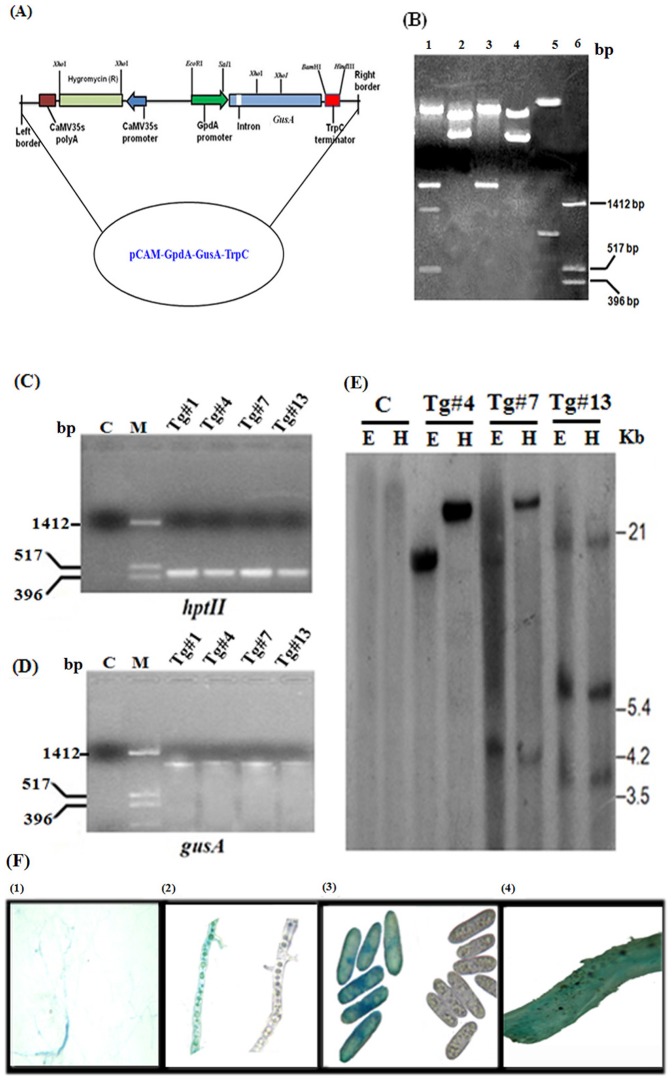
Standardization of Agrobacterium-mediated transformation of Colletotrichum fungus with the gusA reporter gene expression construct, pCAM-GpdA-GusA-TrpC.(A) Schematic diagram of the genetic construct prepared in pCAMBIA1300 binary vector. (B) Ethidium bromide-stained 1.2% agarose gel showing characteristic restriction enzyme digestion profile of the genetic construct with XhoHI (lane 1), EcoRI+HindIII (lane 2), EcoRI+SalI (lane 3), EcoRI+BamHI (lane 4) and BamHI+HindIII (lane 5) along with the pUC18 DNA digested with Hinf1 as molecular weight marker (lane 6). (C) PCR-based screening for the presence of 450 bp hptII selection marker gene-specific amplicon in four (Tg#1, Tg#4, Tg#7 and Tg#13) chosen transformed lines. (D) PCR-based screening for the presence of 1100 bp gusA reporter gene-specific amplicon in the same four transformed lines. In (C) and (D), Lane M =  HinfI digested pUC18 DNA as molecular weight marker (E) Confirming genomic integration of the gusA transgene through Southern hybridization. Genomic DNA samples of three (Tg#4, Tg#7 and Tg#13) transformed lines were digested with EcoR1 (lane E) and HindIII (lane H) seperately, and hybridized with the gusA gene-specific probe. Lambda (λ) DNA digested with EcoRI+HindIII was used as molecular weight marker. In case of (C), (D) and (E), the wild type Colletotrichum sp. DM06 was taken as control (lane C). (F) Histochemical GUS assay in fungal transformant Tg#4 depicting functional activity of the gusA transgene along with the wild type strain as control. Microscopic visualization of GUS activity in different fungal tissues at variable magnifications: mycelium at 10X (1), hypha at 100X (2), spores at 1000X (3) and setae at 40X(4).